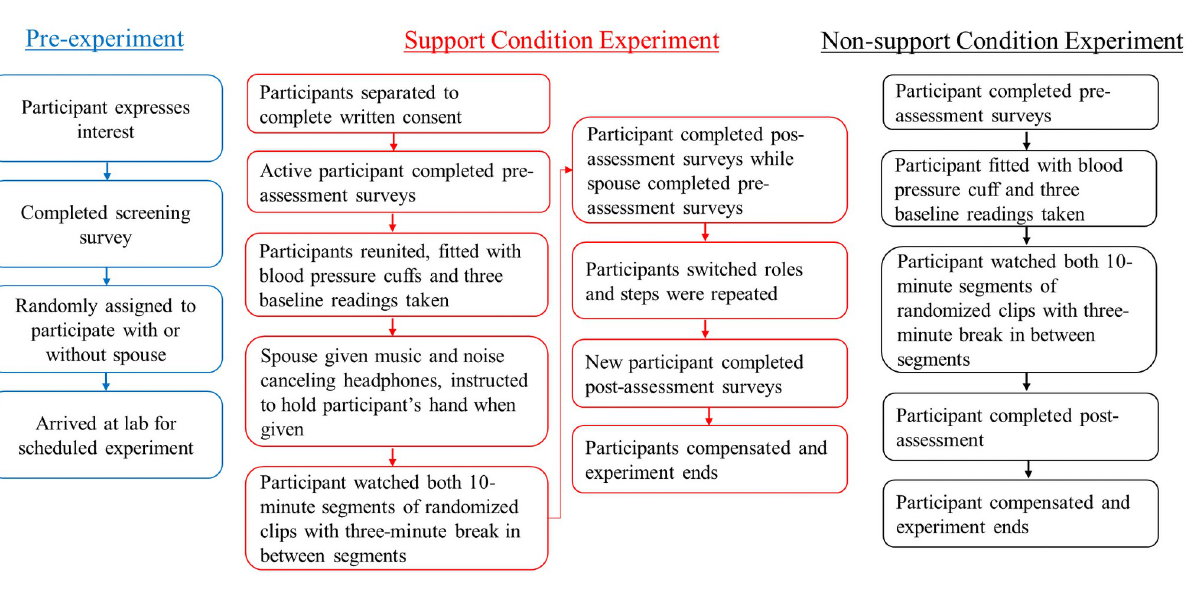
Fig 1. Experiment procedural